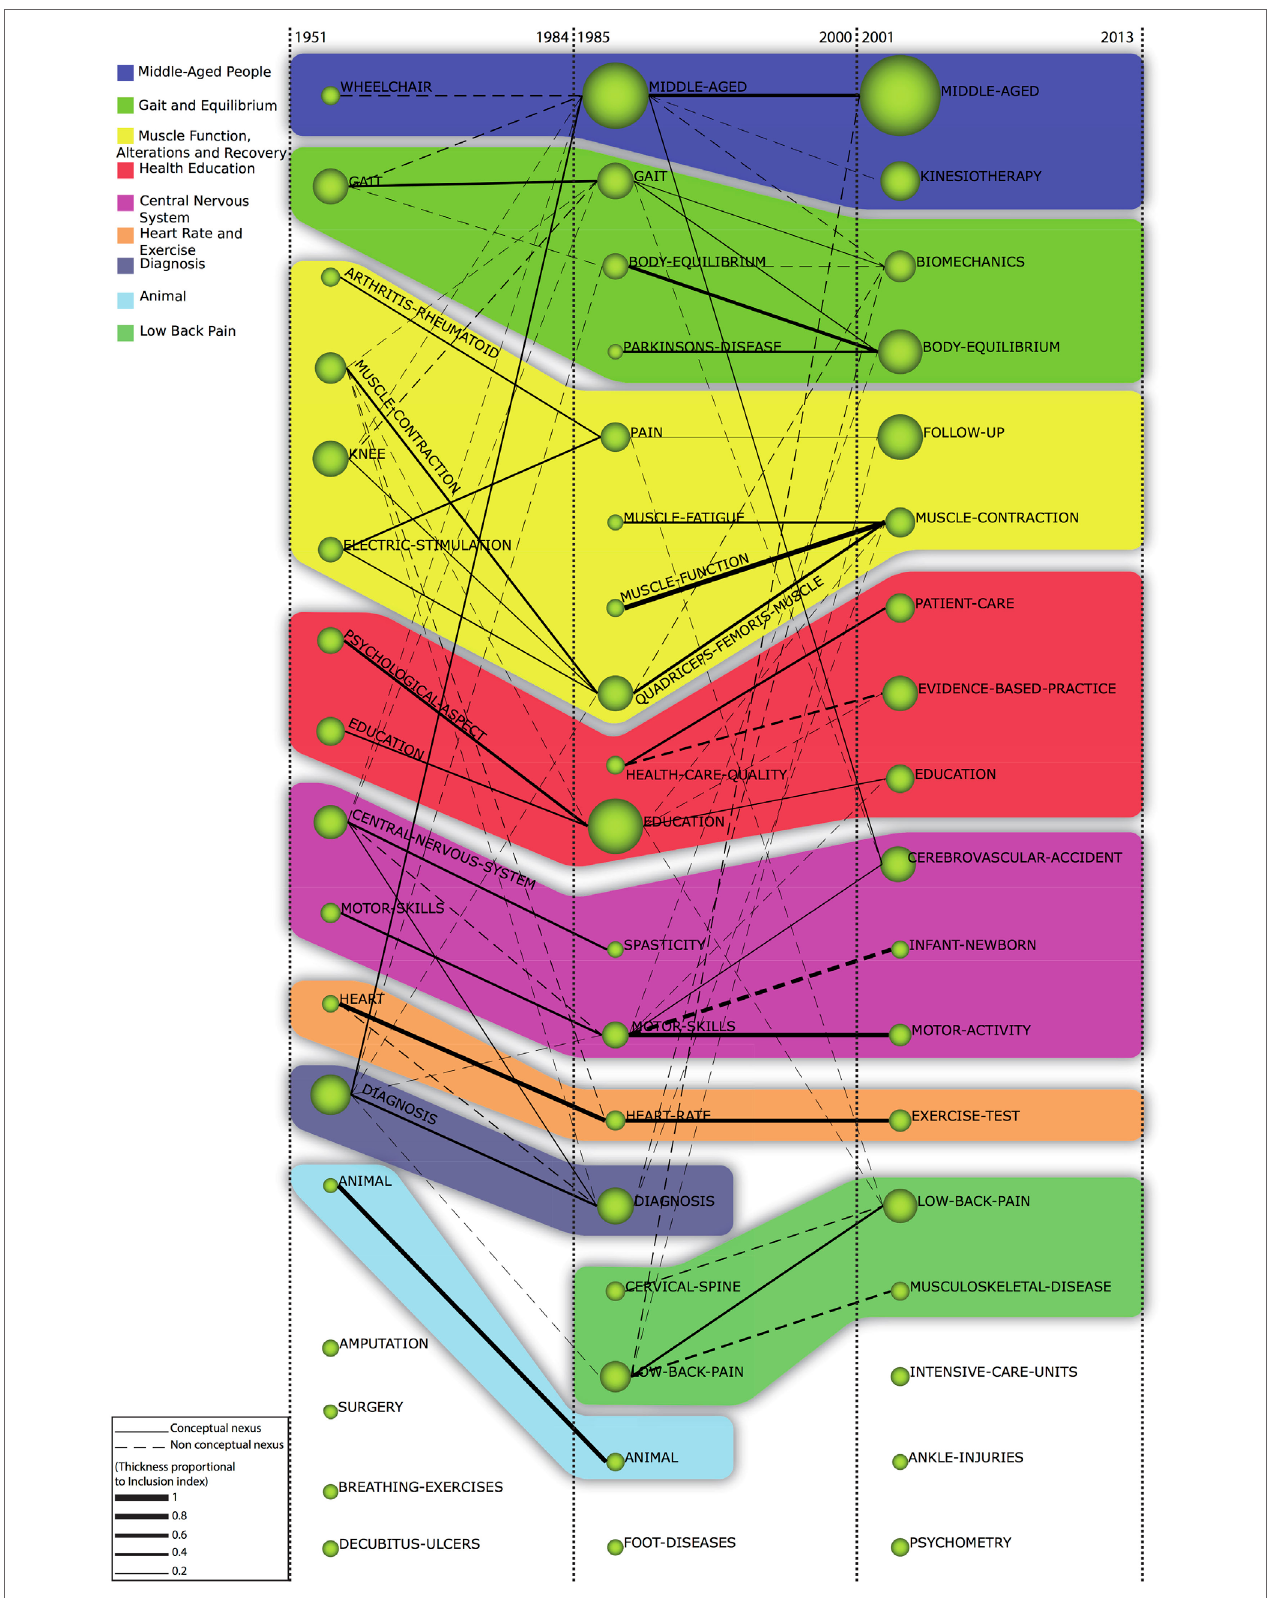
FigUre 6 | Thematic evolution of Physiotherapy